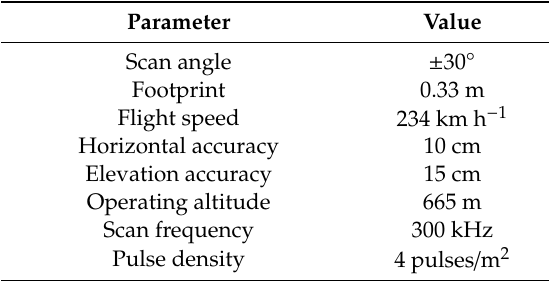
Table 1. Lidar flight characteristics for the point cloud acquisition in the study area.